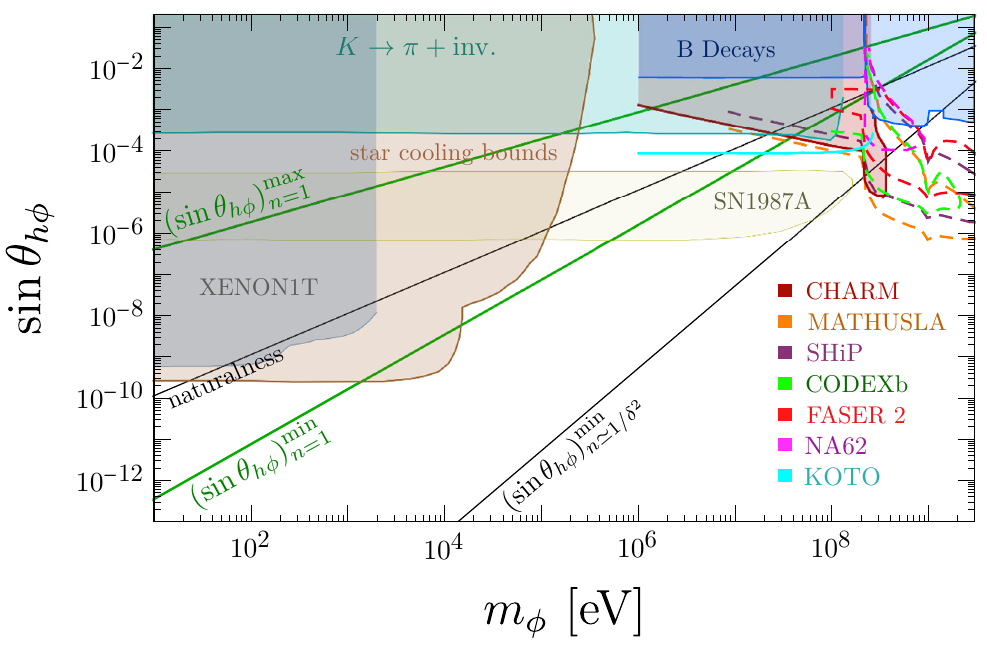
Figure 4 . A relaxion window and the available parameter space for heavier relaxion. The region between the green lines represents the parameter space for relaxion when it is stopped at the (cid:12)rst minimum n = 1. The upper black line represents sin (cid:18) h(cid:30) m (cid:30) =v denoted as \naturalness EW ’ line" in the (cid:12)gure. The lower black line represents minimum mixing angle for a generic Higgs portal model. The yellow shaded region is constrained by SN1987A [36{38] observation. The brown shaded region is excluded by various star-cooling bounds coming from red giants and horizontal branch stars [32, 34, 35], where the gray shaded region is excluded by XENON1T [7] experiment for relaxion production at the solar core. Turquoise shaded region is constrained by E949 experiment [41]. The blue shaded region is excluded by Belle [42], BABAR [43] and LHCb [44, 45]. The red shaded region is excluded by CHARM [46] experiment, whereas the reach of various future accelerator experiments are plotted in dashed lines. Reinterpretation of recent KOTO result [47, 48] is denoted by solid cyan